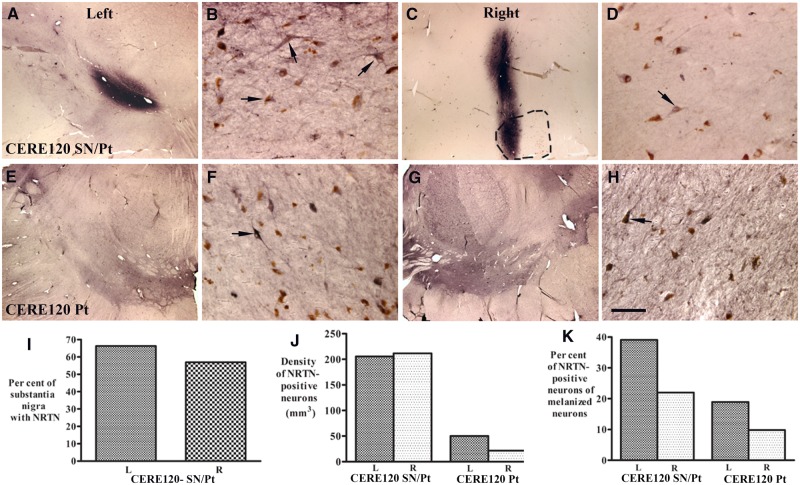

Qualitative and quantitative evaluation for NRTN expression in substantia nigra. Photomicrographs of substantia nigra from Parkinson’s disease subjects with combined nigral and putamenal CERE120 delivery (CERE120 SN/Pt, A–D) or putamenal delivery only (CERE120 Pt; E–H) illustrating neurturin (NRTN) immunohistochemical staining. Note NRTN were diffused into both sides of nigral region (A and C) in Parkinson’s disease with combined nigral and putamenal CERE120 delivery but not in Parkinson’s disease with putamenal delivery only (E and G). NRTN-positive neuros (arrows; B, D, F and H) were detected in substantia nigra of both Parkinson’s disease cases. Outlined area (C) represents substantia nigra with melanized neurons. Scale bars: H, B, D and F = 100 µm; A, C, E and G = 1.6 mm. Cavalieri analyses demonstrated per cent of NRTN covering left (L) and right (R) substantia nigra in Parkinson’s disease with combined nigral and putamenal CERE120 delivery (I). (J) Stereological analyses revealed that the density of NRTN-positive neurons was higher in Parkinson’s disease with combined nigral and putamenal CERE120 delivery (CERE120 SN/Pt) than Parkinson’s disease with putamenal delivery only (CERE120 Pt). (K) There was a higher per cent of NRTN-positive neurons in remaining melanized neurons in Parkinson’s disease with combined nigral and putamenal CERE120 delivery (CERE120 SN/Pt) than Parkinson’s disease with putamenal delivery only (CERE120 Pt).